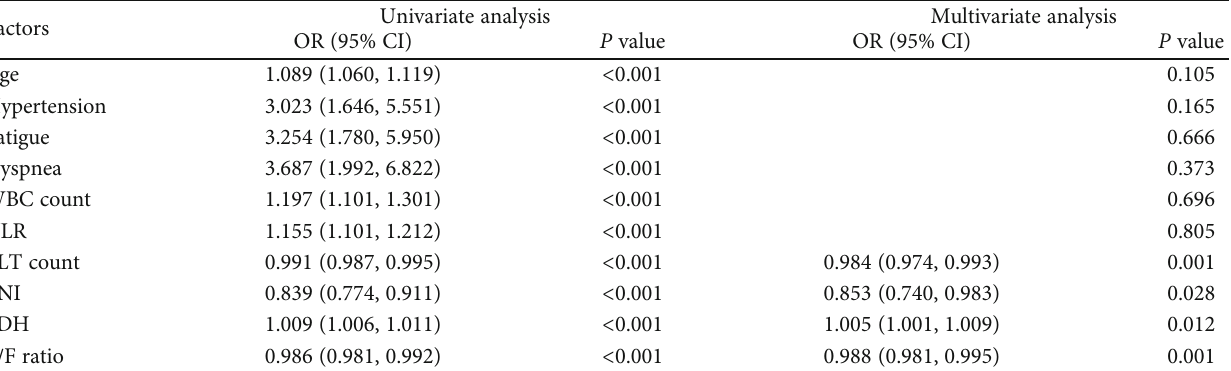
Table 3: Univariate and multivariate logistic analysis of potential prognostic